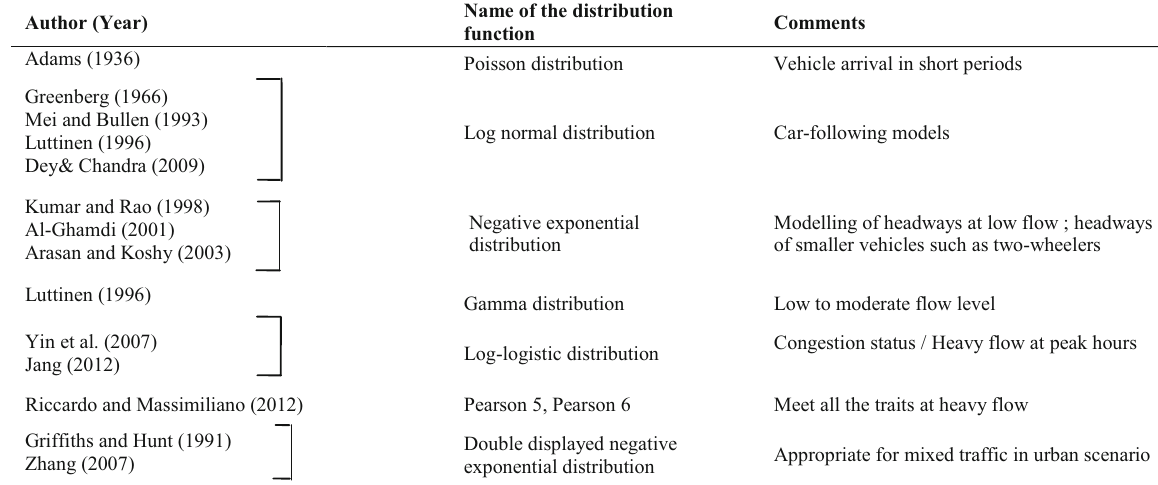
Contestant headway distribution